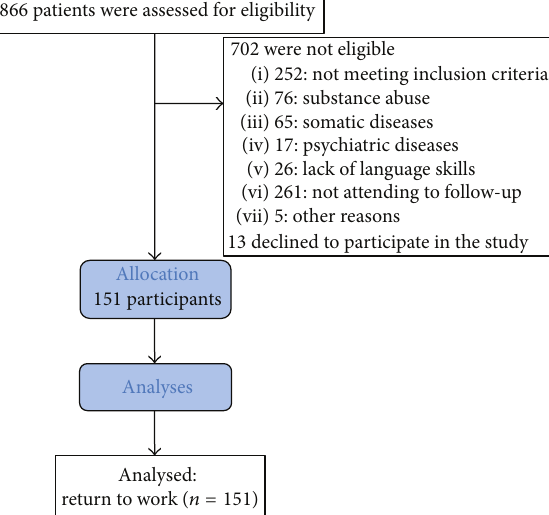
Figure 1: Flow diagram.